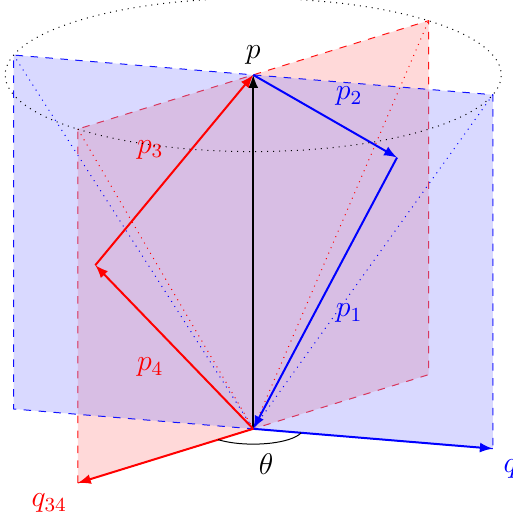
Figure 2: A possible configuration of momenta in the center-of-mass frame (energy along the vertical axis). The scattering angle θ corresponds to the angle between the planes spanned by ( p q . In this particular example p 34 p are all space-like, as seen by their position relative to the light cone (dotted 4